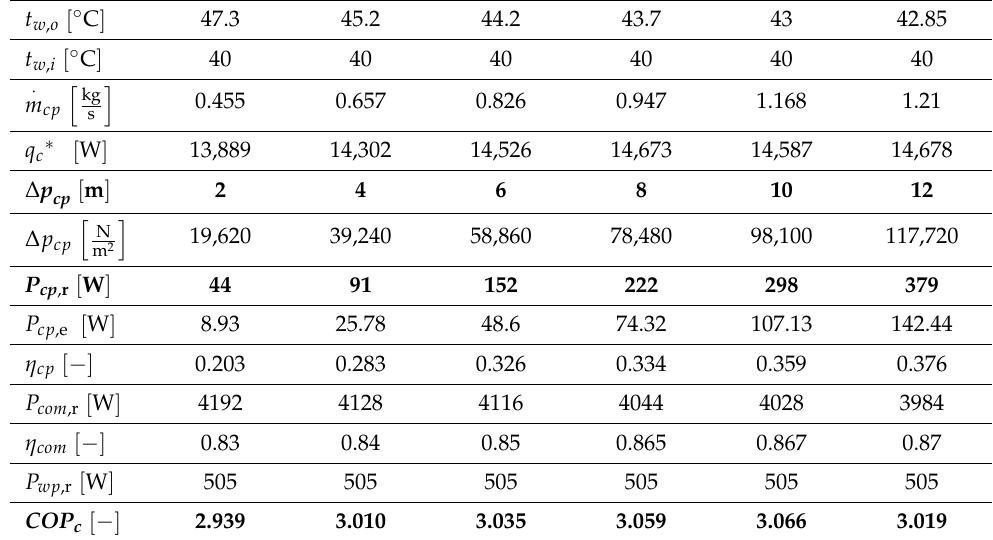
Table 1. Data of the series of